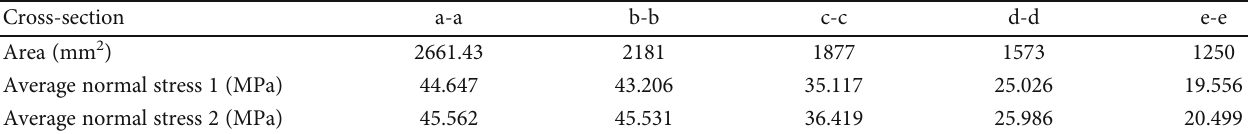
Figure 15: The single-sided connection structure of four rows of bolts. Table 3: The area and average normal stress of